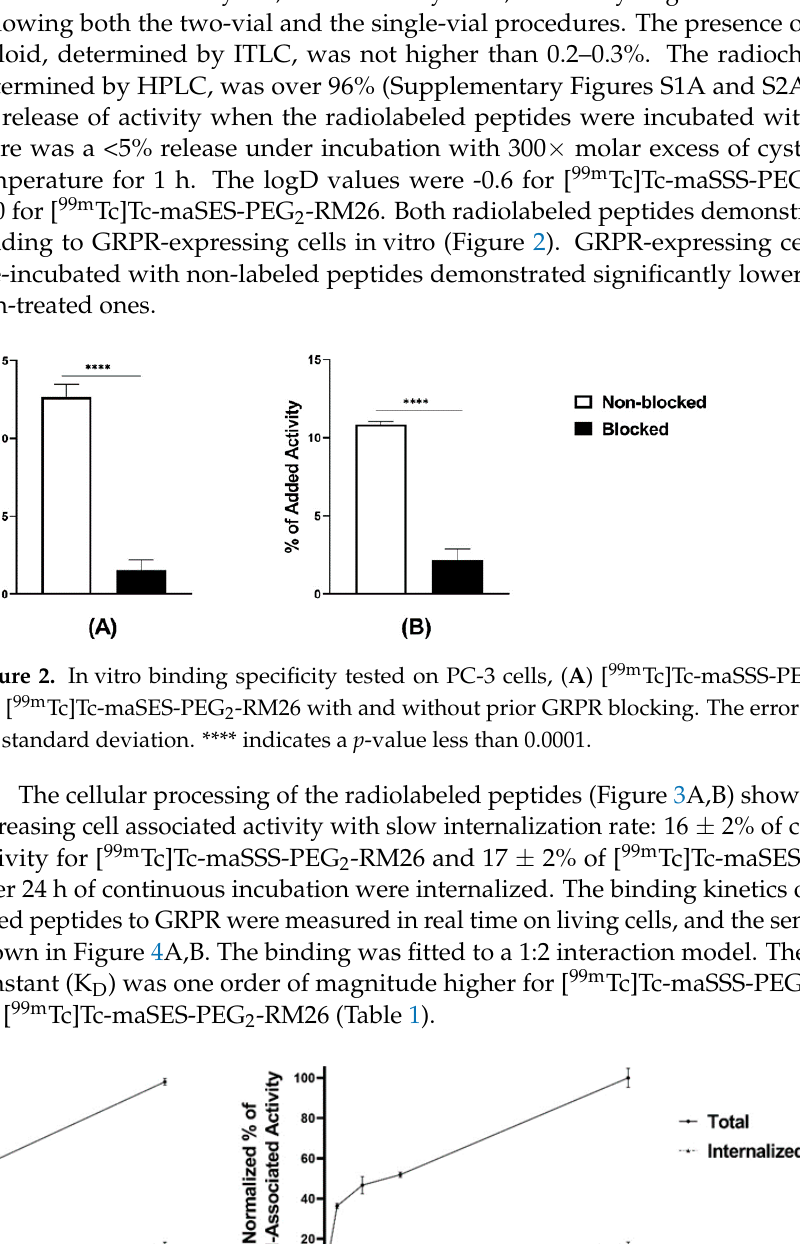
Figure 4. The sensorgrams obtained using LigandTracer Yellow for [ 99m Tc]Tc-maSSS-PEG 2 -RM26 ( A ) and [ 99m Tc]Tc- maSES-PEG 2 -RM26 ( B ). The concentrations during association measurements were 0.5 and 2 nM for each radiolabeled peptide.